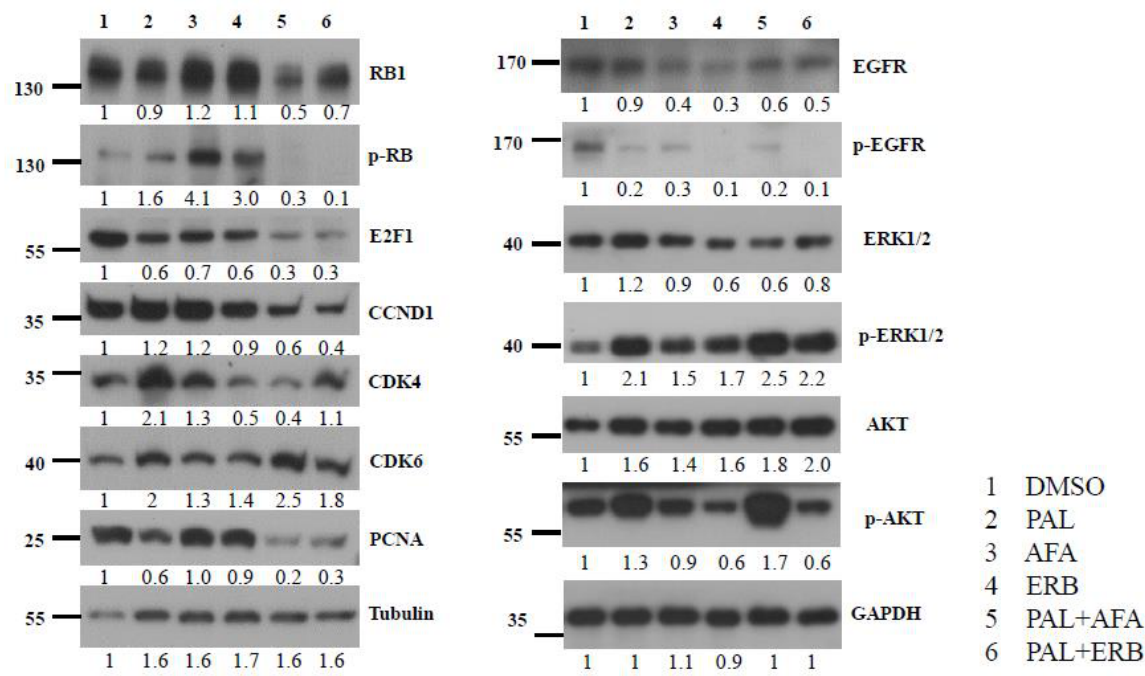
Figure 5. Western blot analysis of key protein molecules of EGFR and cell cycle pathways in NPC PDX-B13 tumors with or without EGFRi and/or palbociclib treatment.